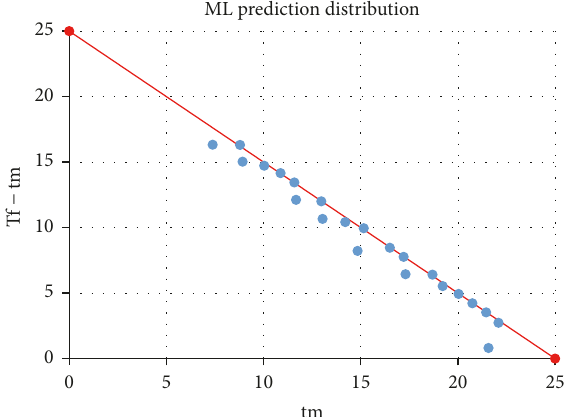
Figure 8: Distribution of failure predictions using ML method. Line AB represents failure